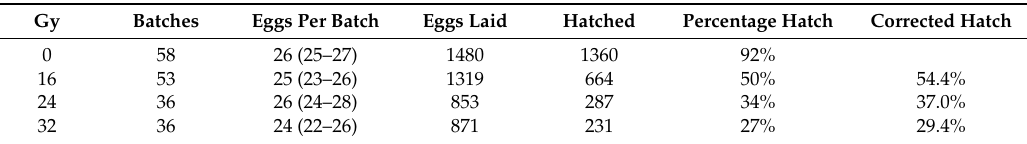
Figure 2. Hatch rate of individual batches of eggs from crosses between irradiated (16, 24 or 32 Gy) or untreated males (0 Gy) mated with virgin females of Halyomorpha halys ; larger symbols show the mean for each dose. Table 1. Hatch rate of all batches of eggs from crosses between irradiated (16, 24 or 32 Gy) or untreated males mated with virgin female Halyomorpha halys . Eggs per batch have 95% confidence limits. Percentage hatch was corrected after Abbott [29].